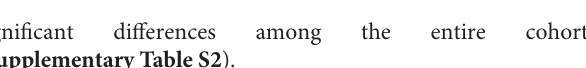
significant differences among the entire cohort ( Supplementary Table S2